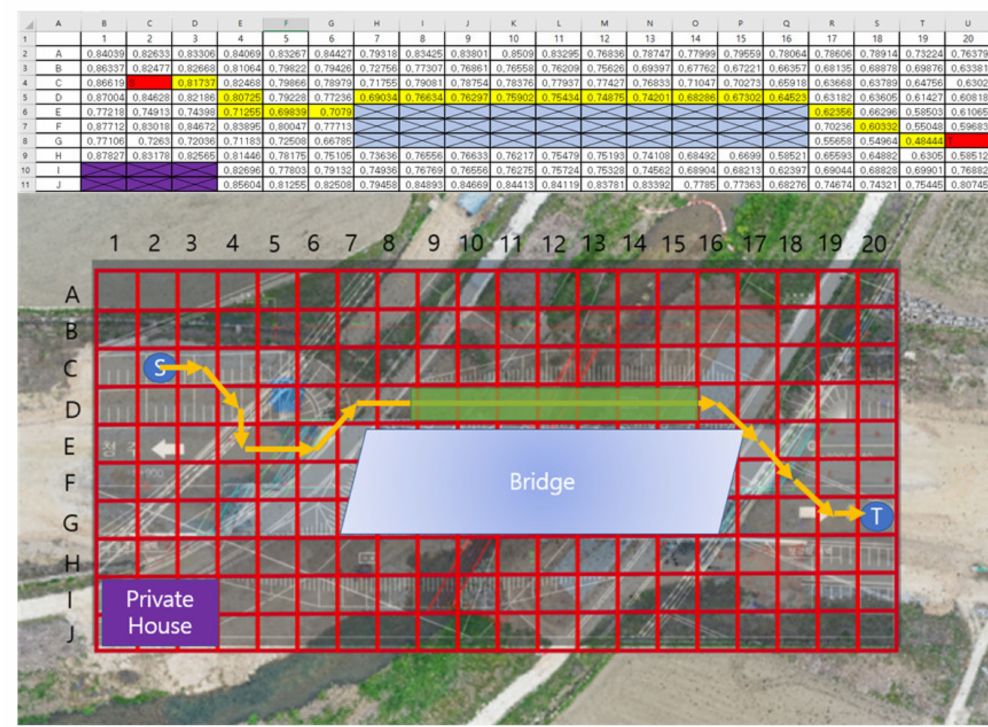
Figure 9. Application of the proposed idea on Chungcheong Inland Expressway, South